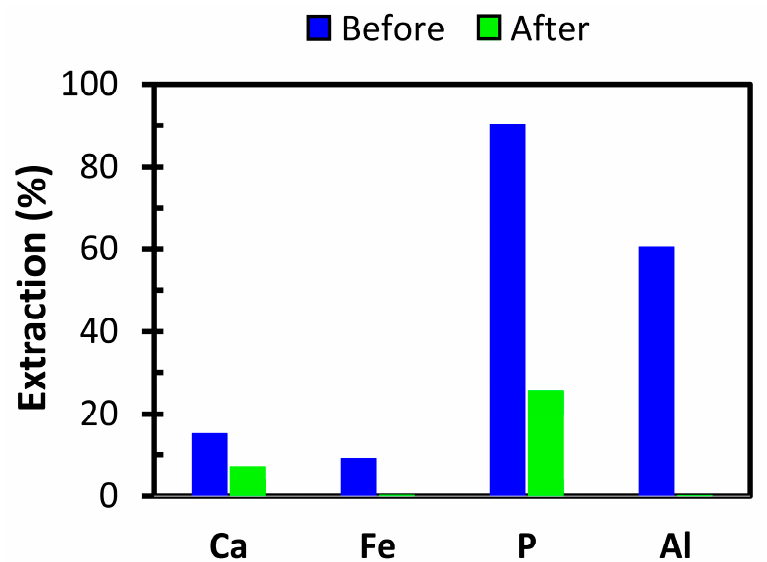
Figure 4. Extraction yields before and after pH variation (initial pH < 1; final pH = 3.7). The analysis on samples was performed by ICP-OES.